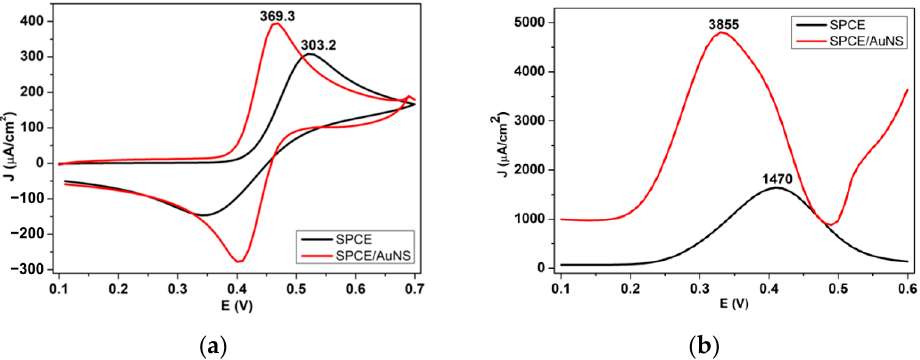
Figure 8. ( a ) CV and ( b ) DPV results of the AuNS-modified SPCE of 1 mM dopamine in 0.1 M HCl.